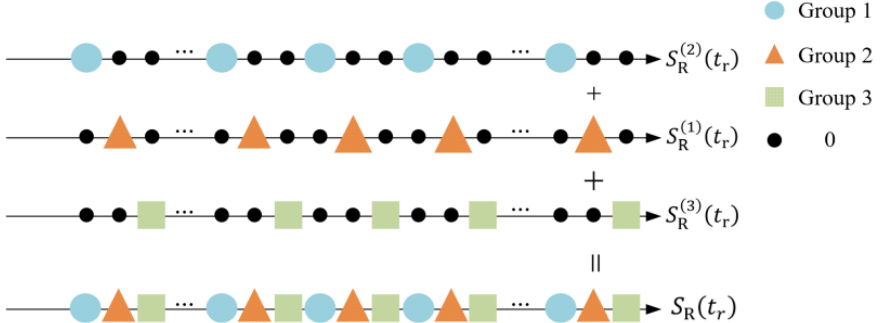
Figure 6. Range direction echo component split diagram (taking 3 groups as an example).